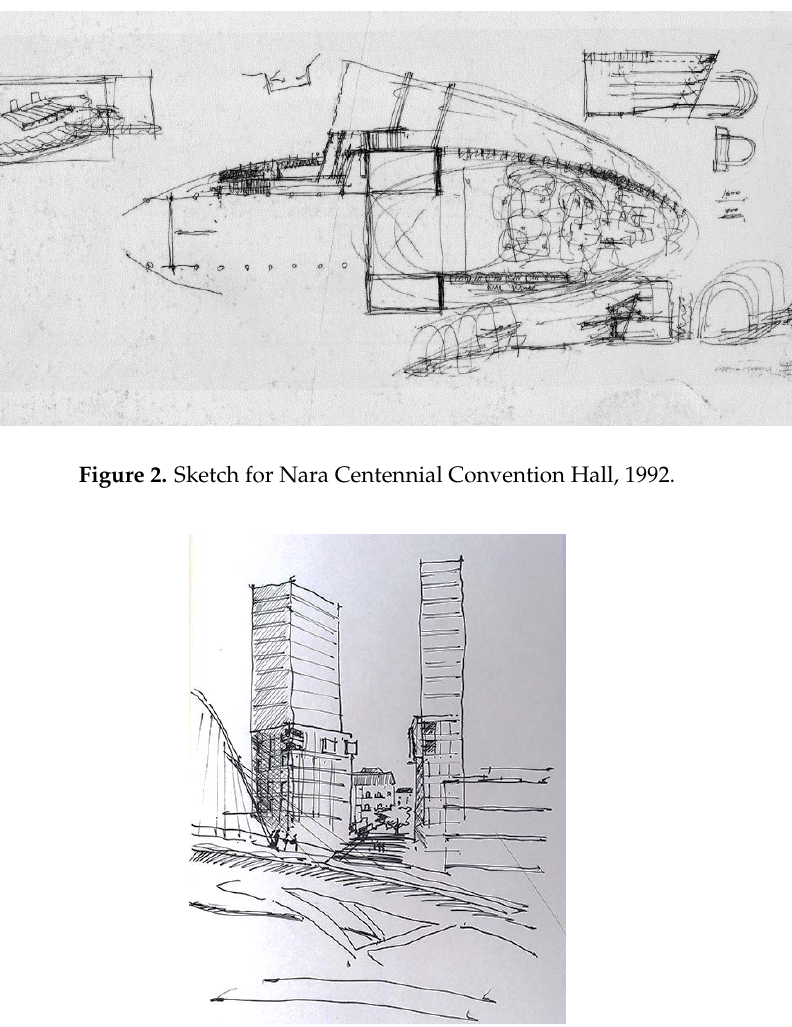
Figure 3. Sketch for Atea Bilbao Twin Towers, 1999.